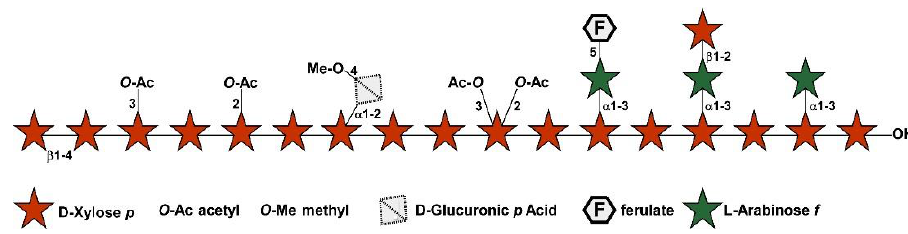
Figure 1. Representation of xylan structures found in monocots and dicots, modified from [8].